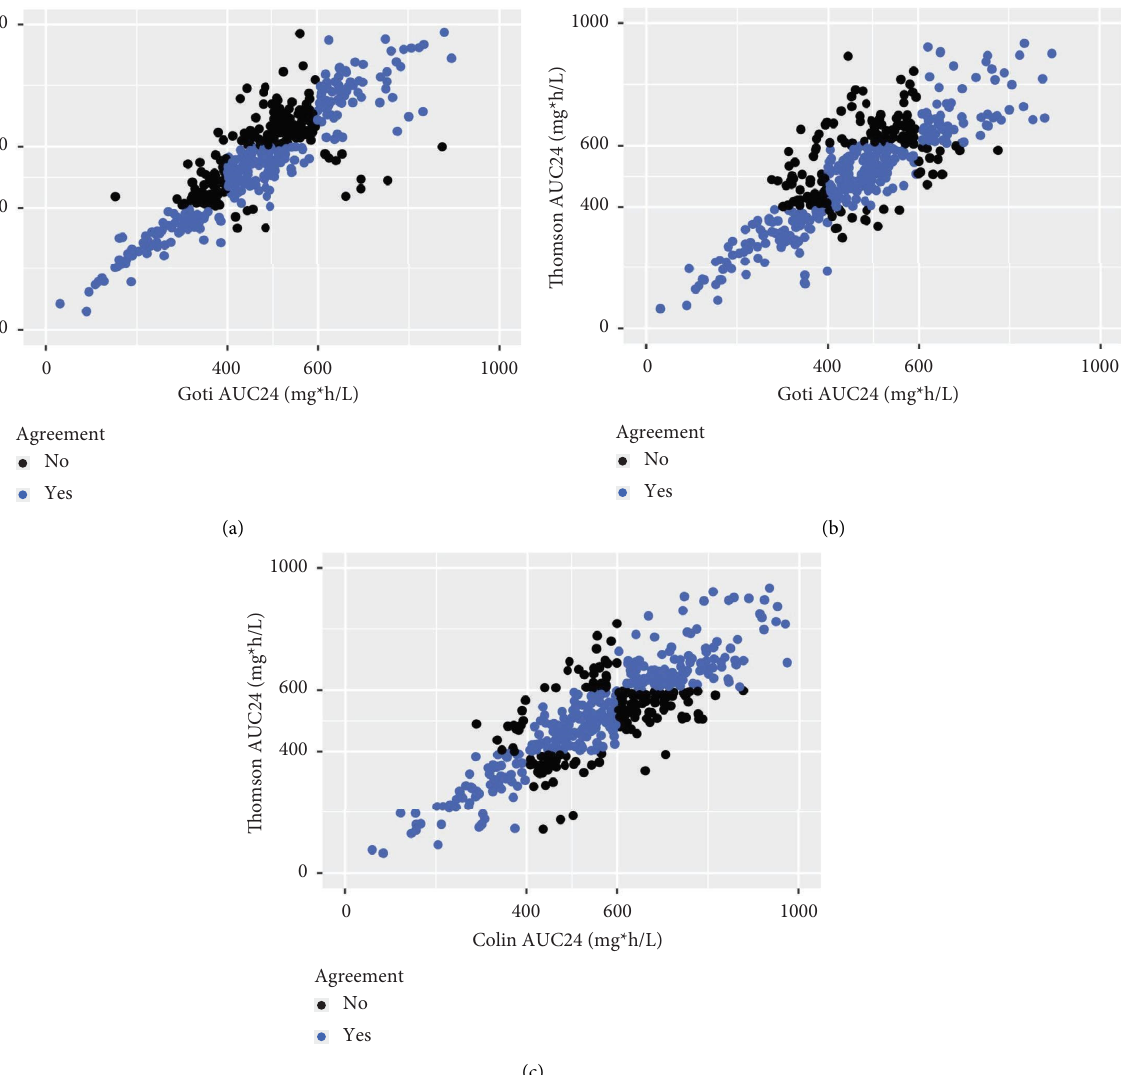
Figure 2: Scatter plot of AUC � agreement; black dots � no agreement; (a) Goti vs Colin models; 24 comparisons between models. Blue dots (b) Goti vs Tomson models; and (c) Tomson vs Colin